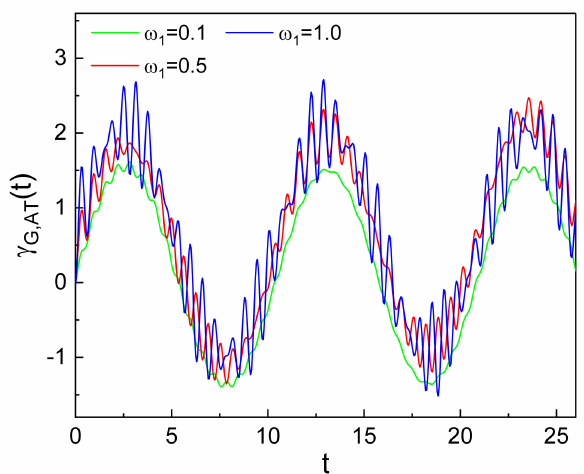
Figure 6. Enlarged view of the temporal evolution of the additional term, γ G ,AT ( t ) , of the geometric phase for several different values of ω 1 . We used ω 2 = 0.6, ξ 0 = 1, λ = 0, ω = 10, ϕ = θ = 0, γ 0 = 0, α 0 = 5, q 0 = 6, p 0 = 5, c 1 = c 2 = 0.05, (cid:101) = 1, and ¯ h = 1. From this figure, we can